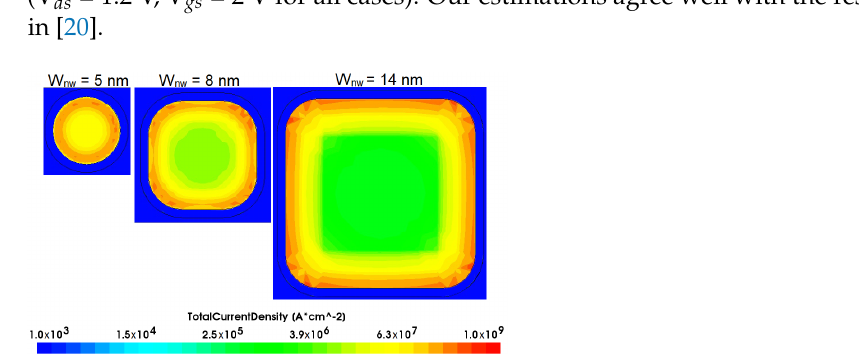
Figure 9. Simulated current density profile at a cross-sectional plane perpendicular to the channel of n-NWFET for varying W nw